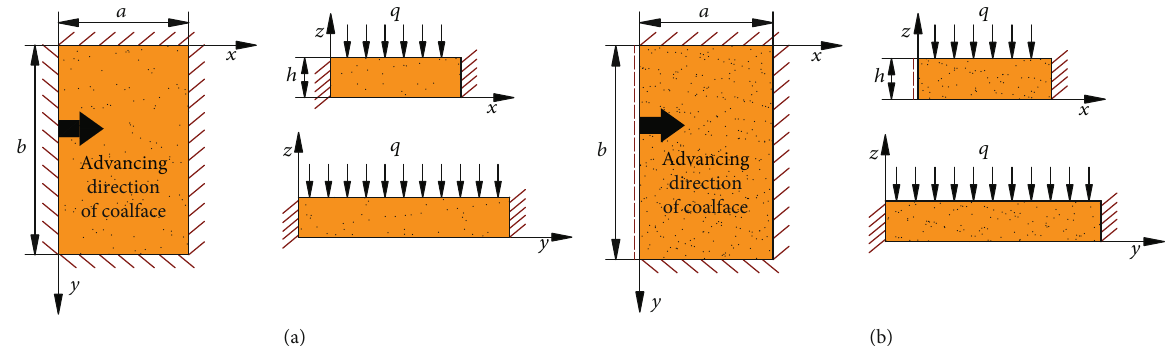
Figure 2: TPMM of the main roof breaking: (a) fi rst breaking model and (b) periodic breaking